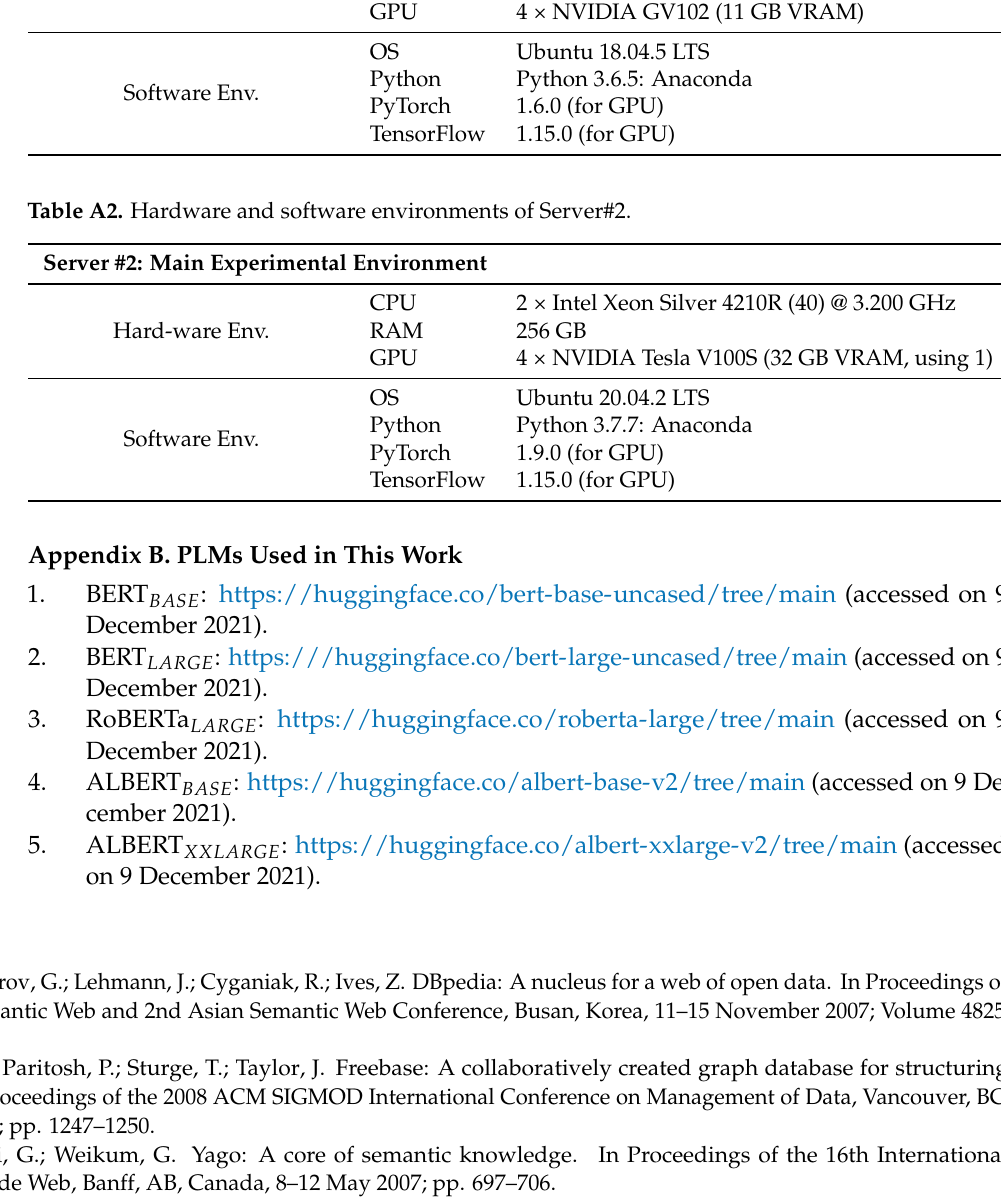
Table A1. Hardware and software environments of Server#1. Server #1: Providing BERT Embedding Service Hard-ware Env.